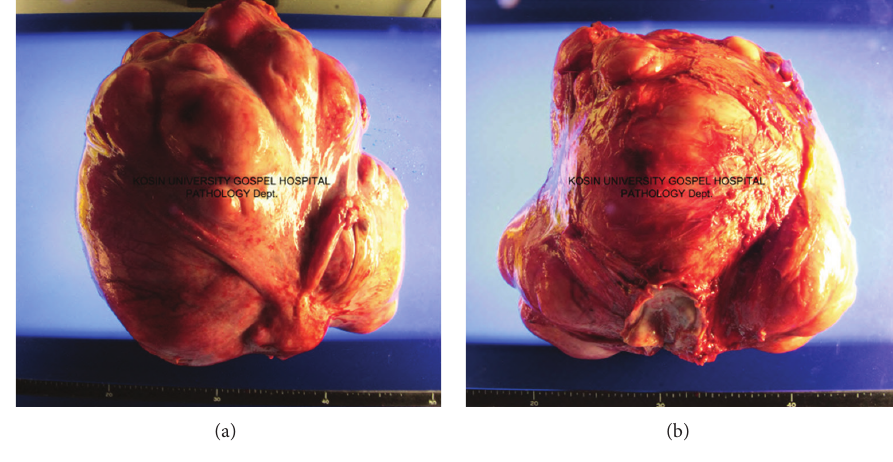
Figure 3: Macroscopic view of uterine fibroid